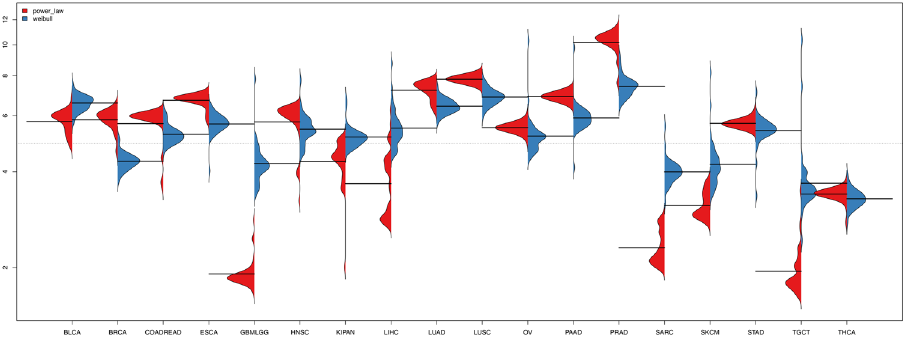
Figure 7. Number of driver mutations required for cancer onset estimated by classical power law model (red) and our scaled Weibull model